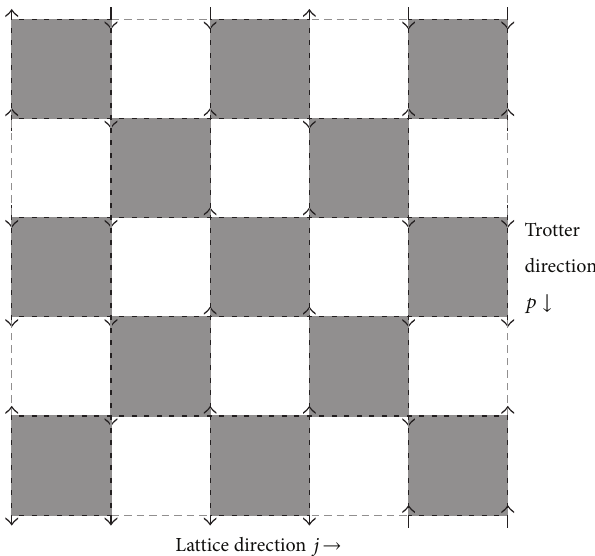
Figure 1: Lattice representation of a class of classical systems equivalent to the general class of quantum systems (9). Spins only interact with other spins bordering the same shaded